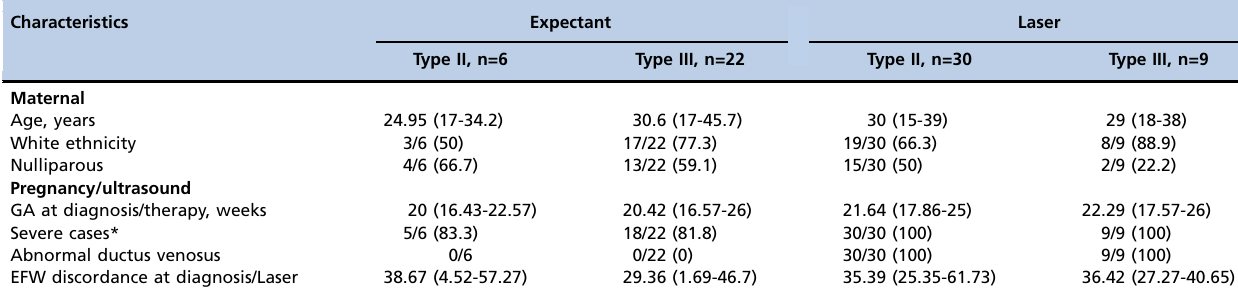
Table 1 - Baseline characteristics of the study population of monochorionic twin pregnancies with type II or III Doppler patterns according to management strategy (expectant management or laser ablation of placental vessels). Characteristics